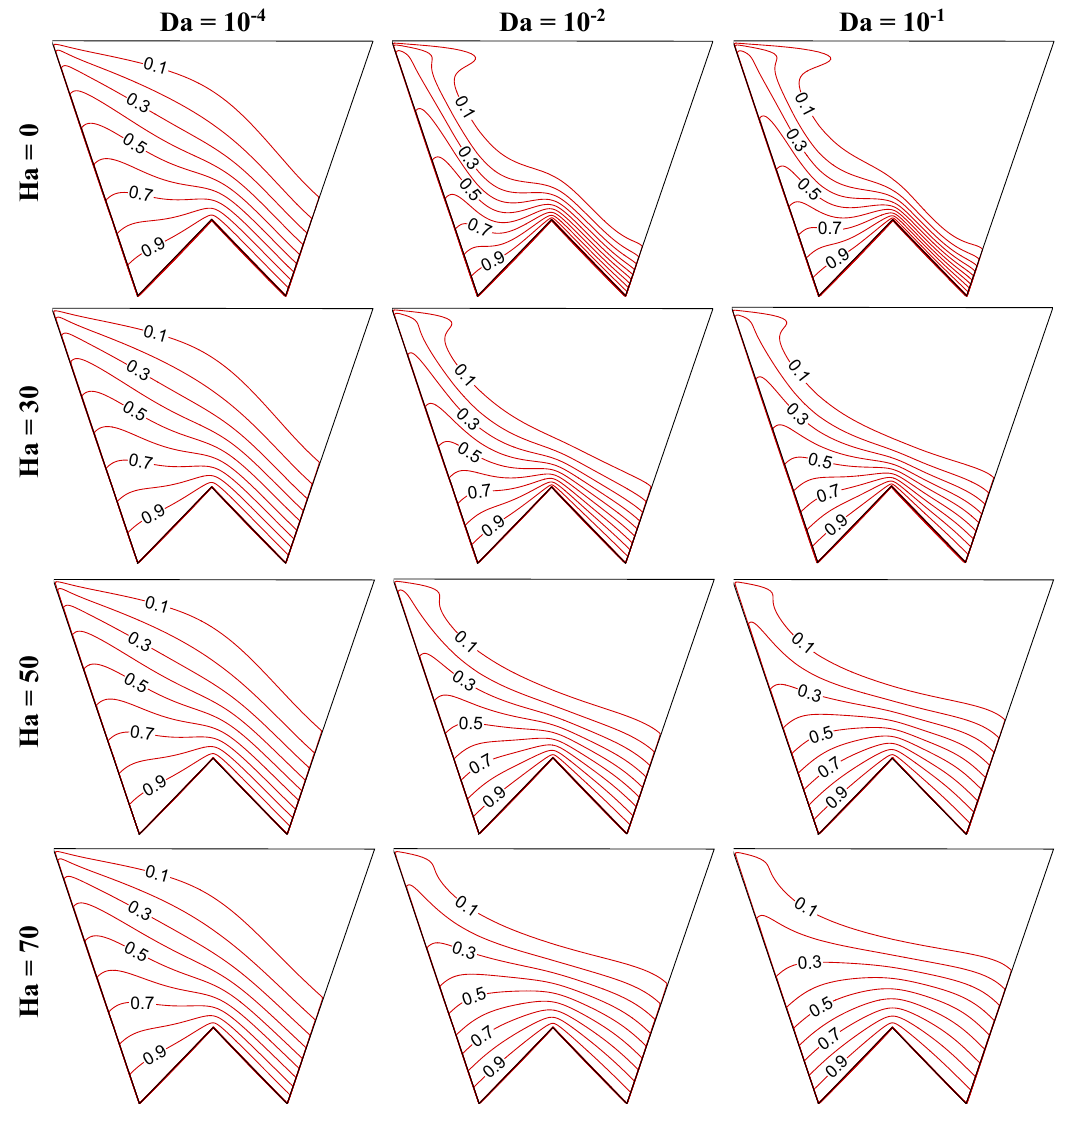
Figure 16. Isotherm contours ( θ ) at R b = 50, Le = Pe = 1, Gr = 10 4 , m = 1, δ = 0.3, γ =